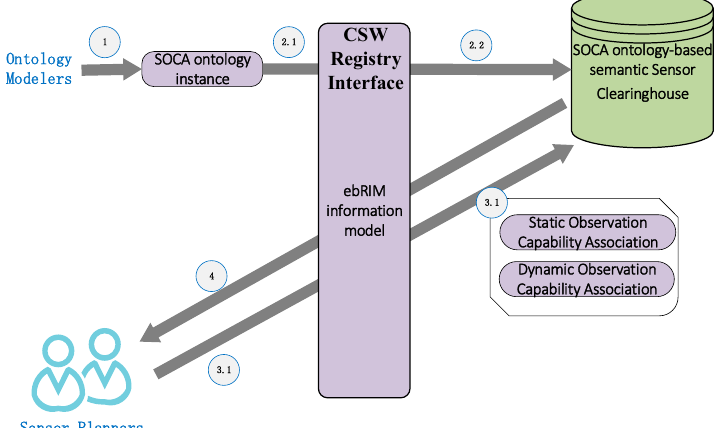
Figure 9. The overall flows to implement the SOCA ontology based observation capability semantic